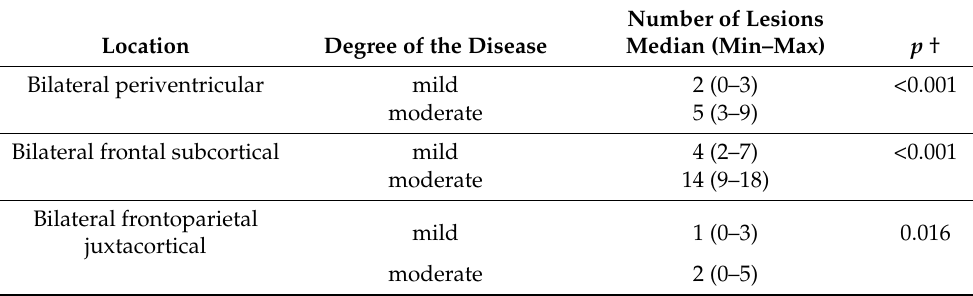
Table 8. Display of median (min–max) number of lesions at three locations in relation to disease